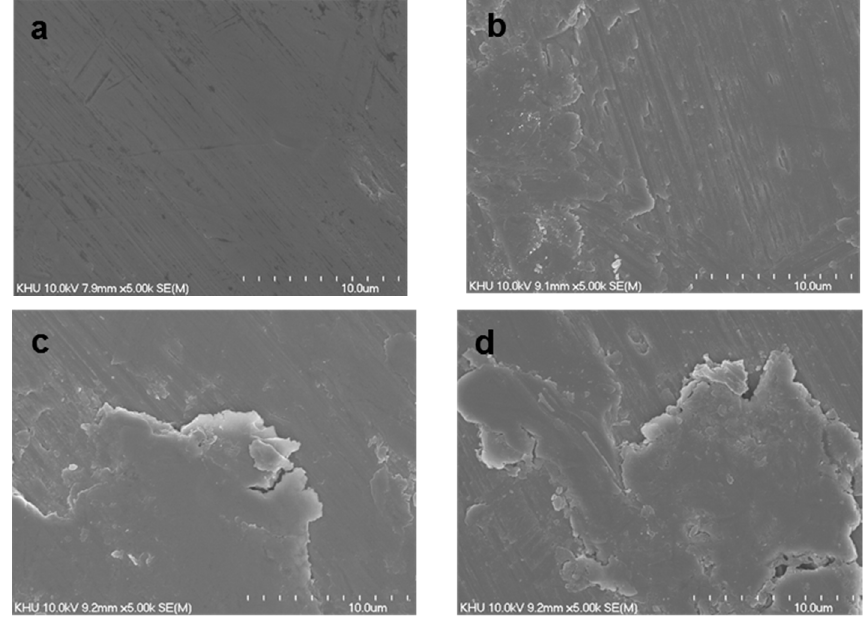
Figure 2. SEM images of ( a ) pristine Ti; ( b ) hBMP-2/Ti; ( c ) hGDF-5/Ti; and ( d ) hBMP-2/hGDF-5/Ti samples observed at 5000× magnification.